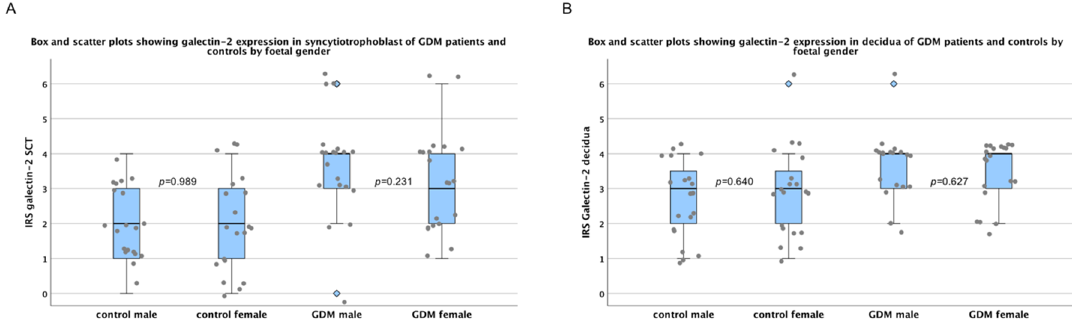
Figure 1. Sex-disaggregated galectin-2 expression. Box and scatter plots show the immunoreactivity score (IRS) for galectin-2 expression by fetal gender in syncytiotrophoblast (SCT; A ) and decidua ( B ). The range between the 25th and 75th percentiles is represented by the boxes, with the horizontal line showing median. The bars indicate the 5th and 95th percentiles. Blue diamonds indicate values more than 1.5-times the boxes’ lengths. Grey dots represent singular data points. There was no statistically significant difference between the male and female groups, as shown by the p -values.